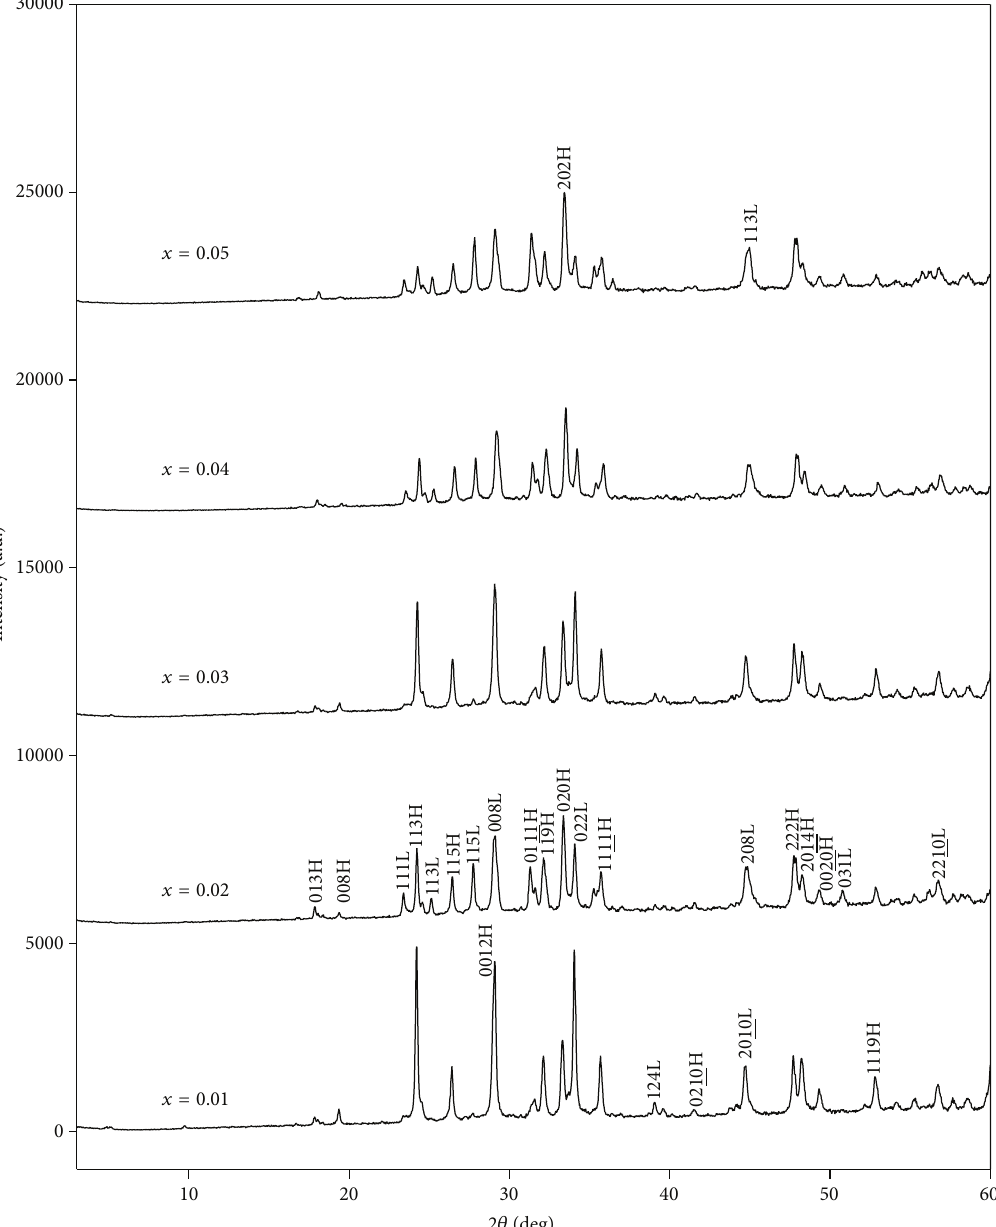
Figure 4: XRD patterns of 50 nm Co 3 O 4 added Bi-2223 samples. (H) denotes the high- 𝑇 𝑐 phase (Bi-2223) and (L) denotes the low- 𝑇 𝑐 phase